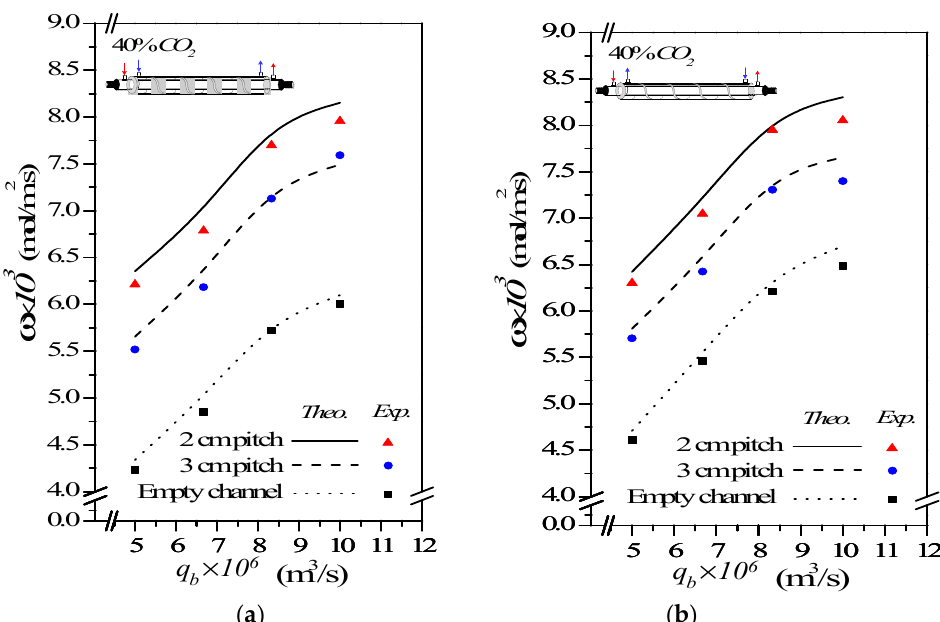
Figure 10. Effects of MEA flow rate and inlet CO 2 feed concentration on CO 2 absorption flux. ( a ) Concurrent-flow operations; ( b ) Countercurrent-flow operations.